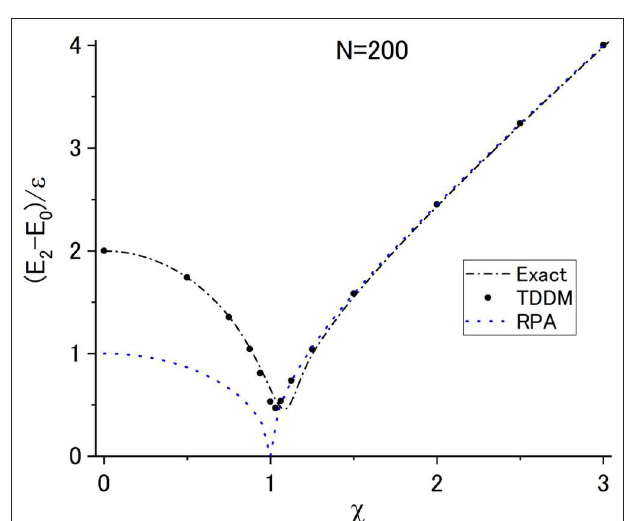
FIGURE 4 | Same as Figure 3 but for the second excited state. The dotted line depicts the RPA results for the first excited state. Adapted from 1. Adapted ≈ a Italiana di `